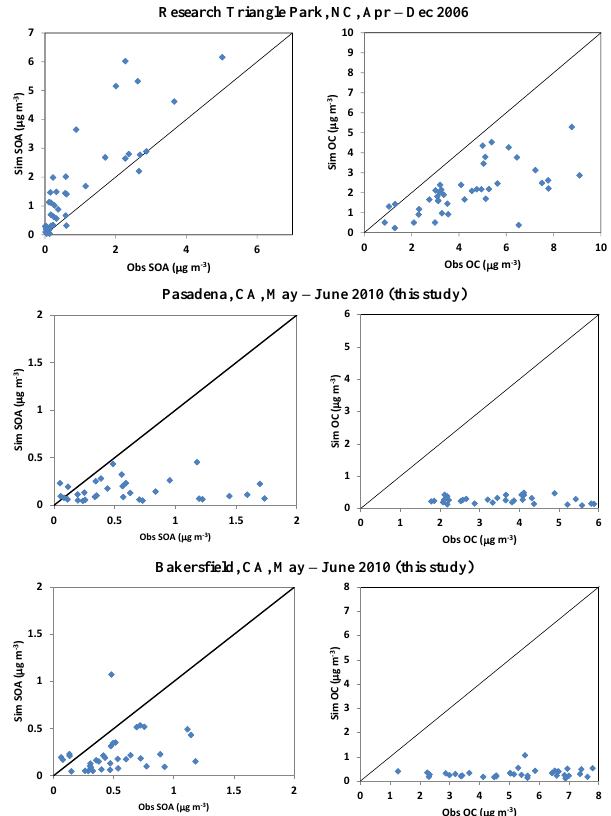
Figure 9. Scatter plots of SOA (left column) and OC (right column) concentrations at various